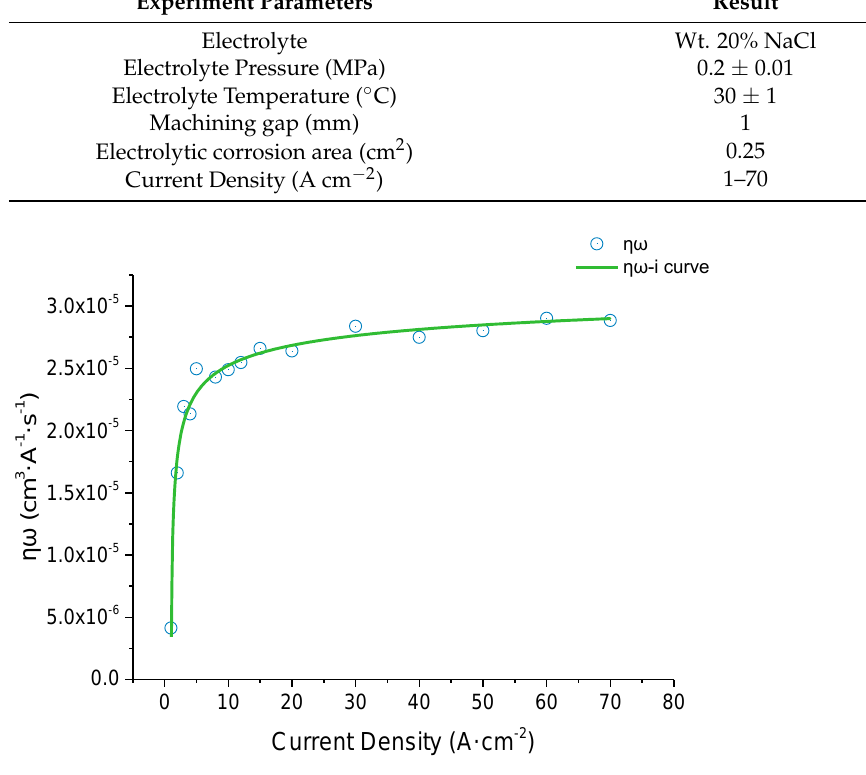
Figure 1. (TiB+TiC)/TC4 ηω - i curve, where ηω represents the actual volume electrochemical equivalent. As the current density increases, ηω first increases rapidly and then stabilizes.